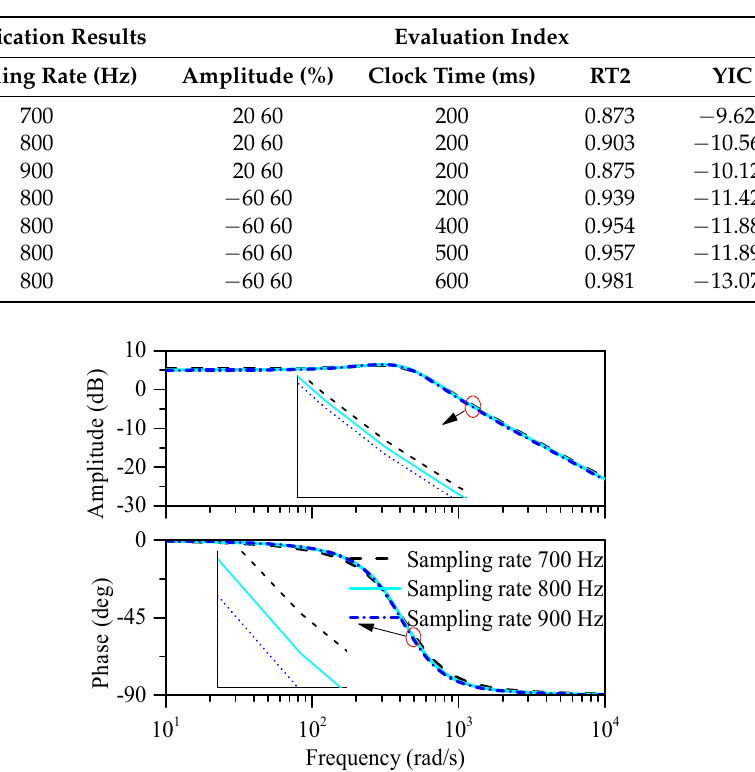
Figure 7. Comparison of the experimental and identification results at sampling rate of 800 Hz.